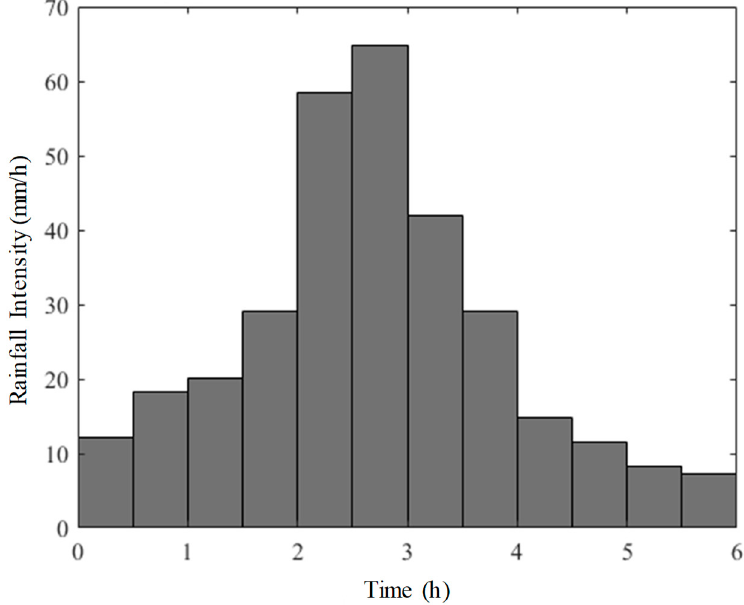
Figure 8. Design hyetograph for 6-hour duration of 5-year return period.